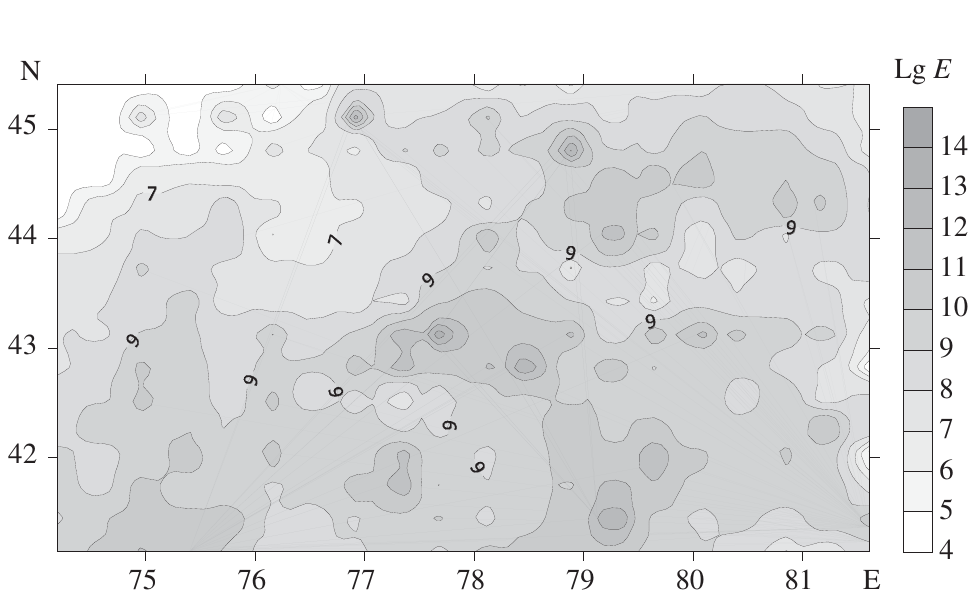
Fig. 2. Map of the flow of total seismic energy of earthquakes in Northern Tien Shan and adjacent territories obtained using all earthquakes of the catalog for 1000 km 2 cells of grid. The values of energy are reduced to the flow for 1 year.